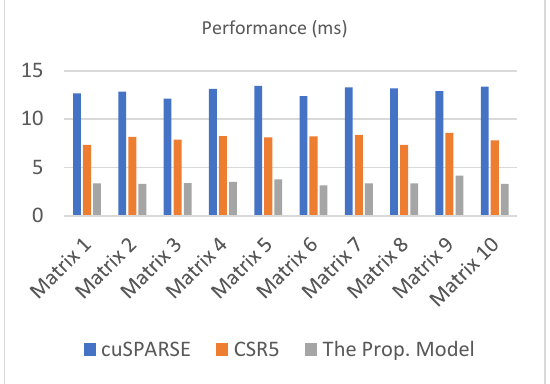
The Prop. Model Figure 6. Performance with block size of 32. Figure 6. Performance with block size of 32.